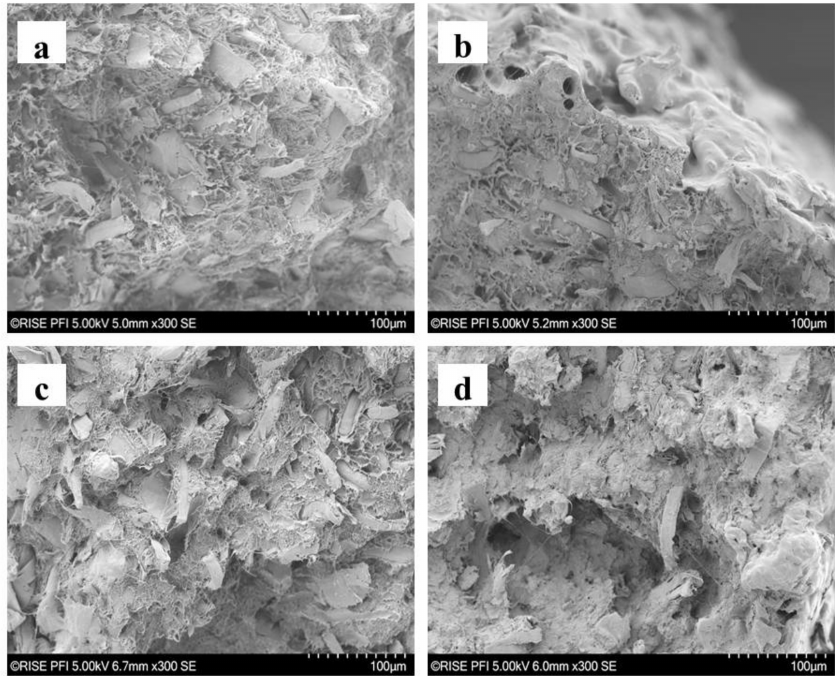
Figure 4. SEM microphotograph of the tensile breaking area: ( a ) 40HT-F filament, ( b ) 20HT-F filament, ( c ) 40HT-B filament, and ( d )